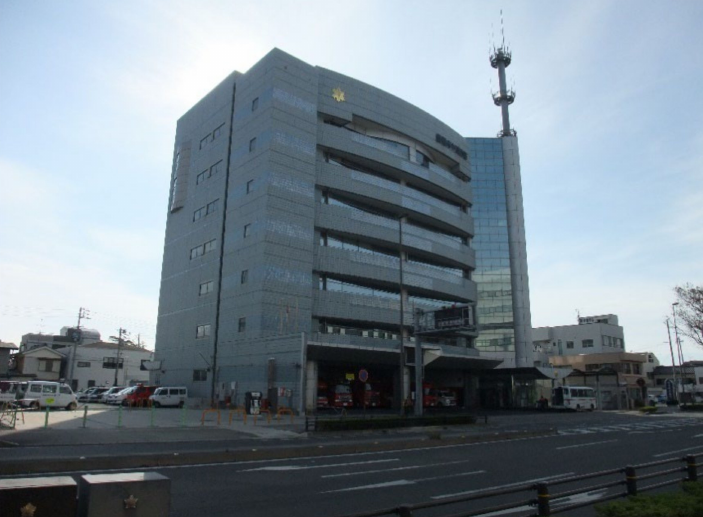
Figure 4. Toyohashi Fire Station Building.